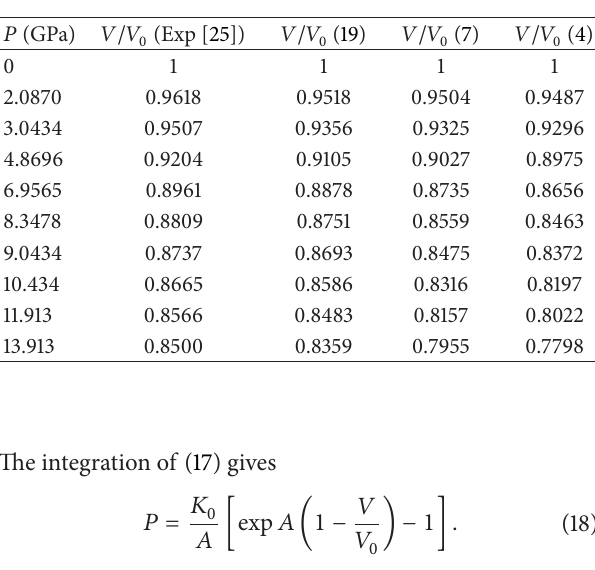
Table 2: Volume compression with pressure for graphite. Table 3: Variation of bulk modulus with